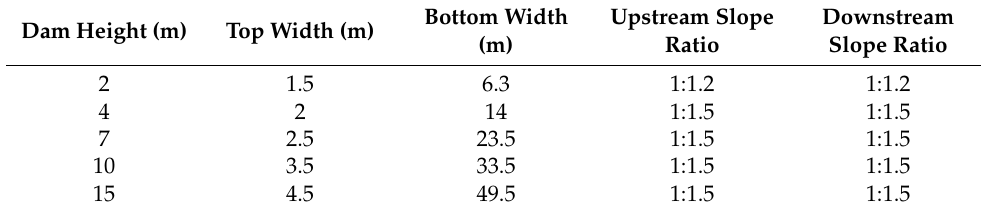
Figure 4. Model water supply and rainfall equipment. Table 3. Sectional dimensions of the prototype